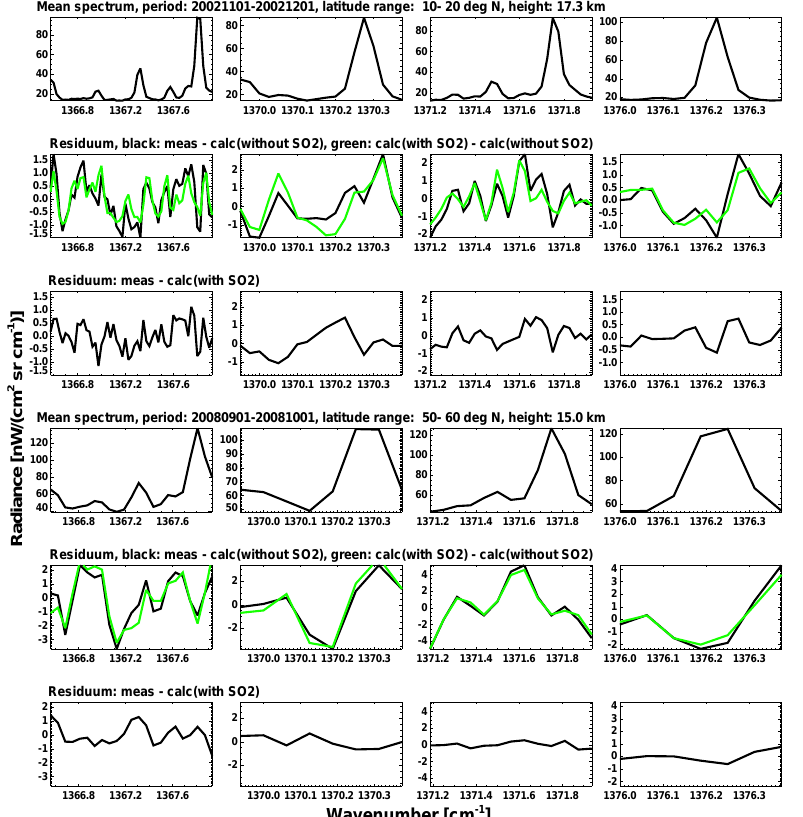
Fig. 1. Spectral identification and fit quality of the SO 2 retrieval. The columns show the four spectral windows used. The top three rows refer to the first observational period (P1), while rows 4–6 belong to the second period with lower spectral resolution (P2). Rows 1 and 4 contain the measured spectra. The black curves in the panels of row 2 and 5 show the residua after the spectral fit when no SO 2 is considered, and the black curves in row 3 and 6 are the residua in the case where SO 2 is added as a fitting parameter. The green curves in row 2 and 5 indicate the spectral features of SO 2 based on simulations